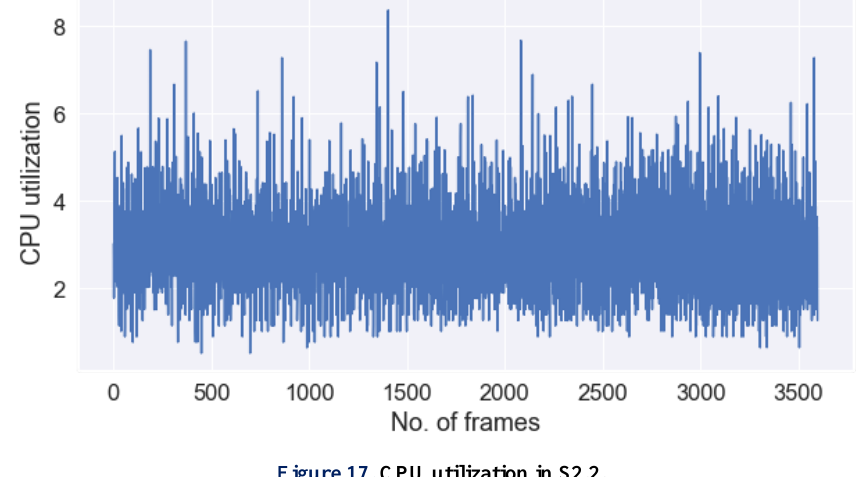
Figure 17. CPU utilization in S2.2.